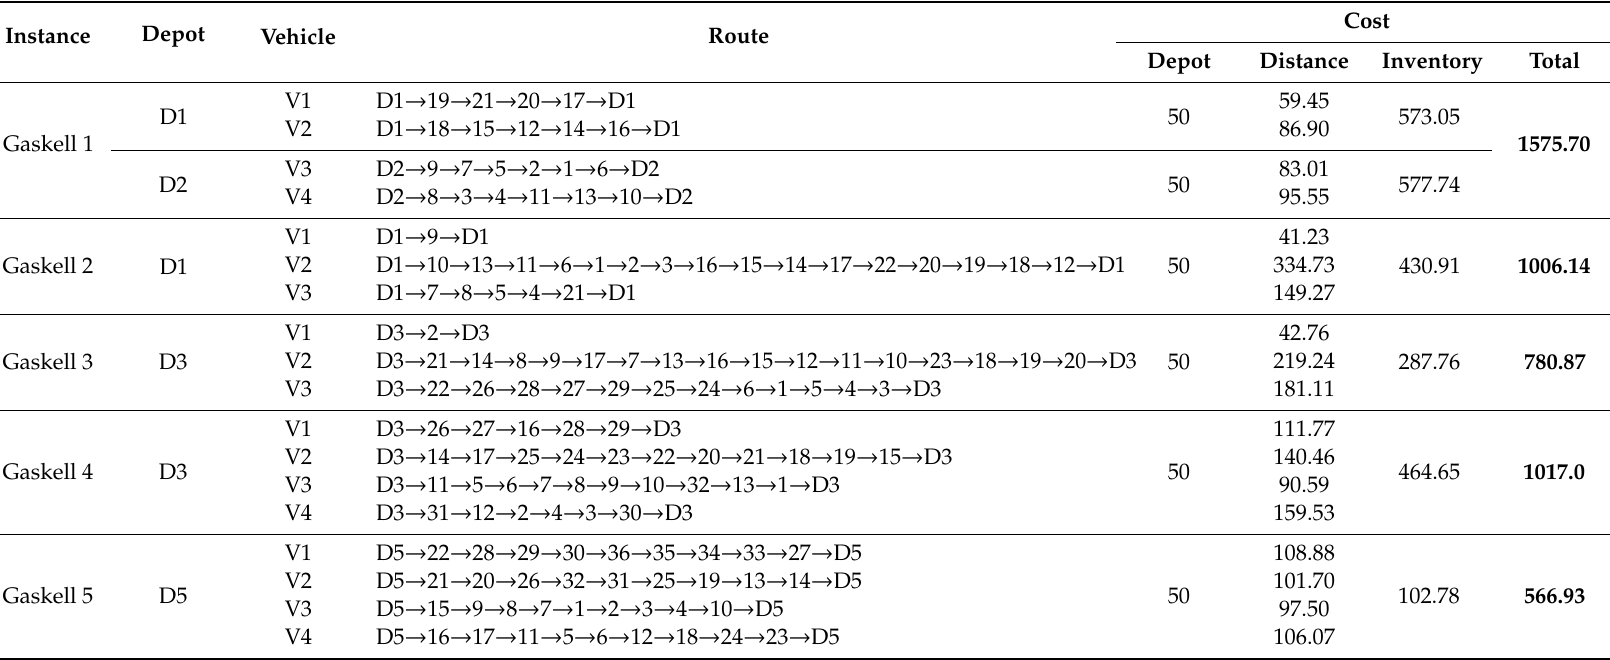
Table 10. Distribution of routes and costs for Gaskell dataset generated by HS-SA for